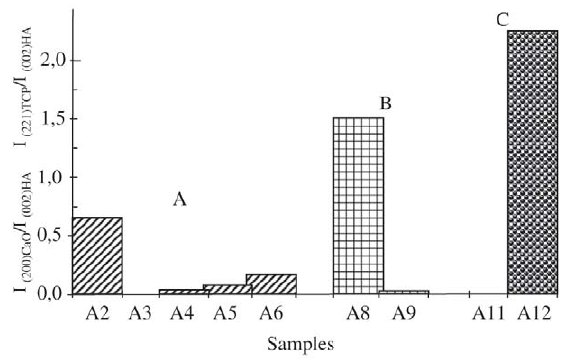
Figure 6. XRD patterns of the synthetic precipitate powders after thermal treatment on R2 (samples A8 and A9) and R3 (samples A11 and